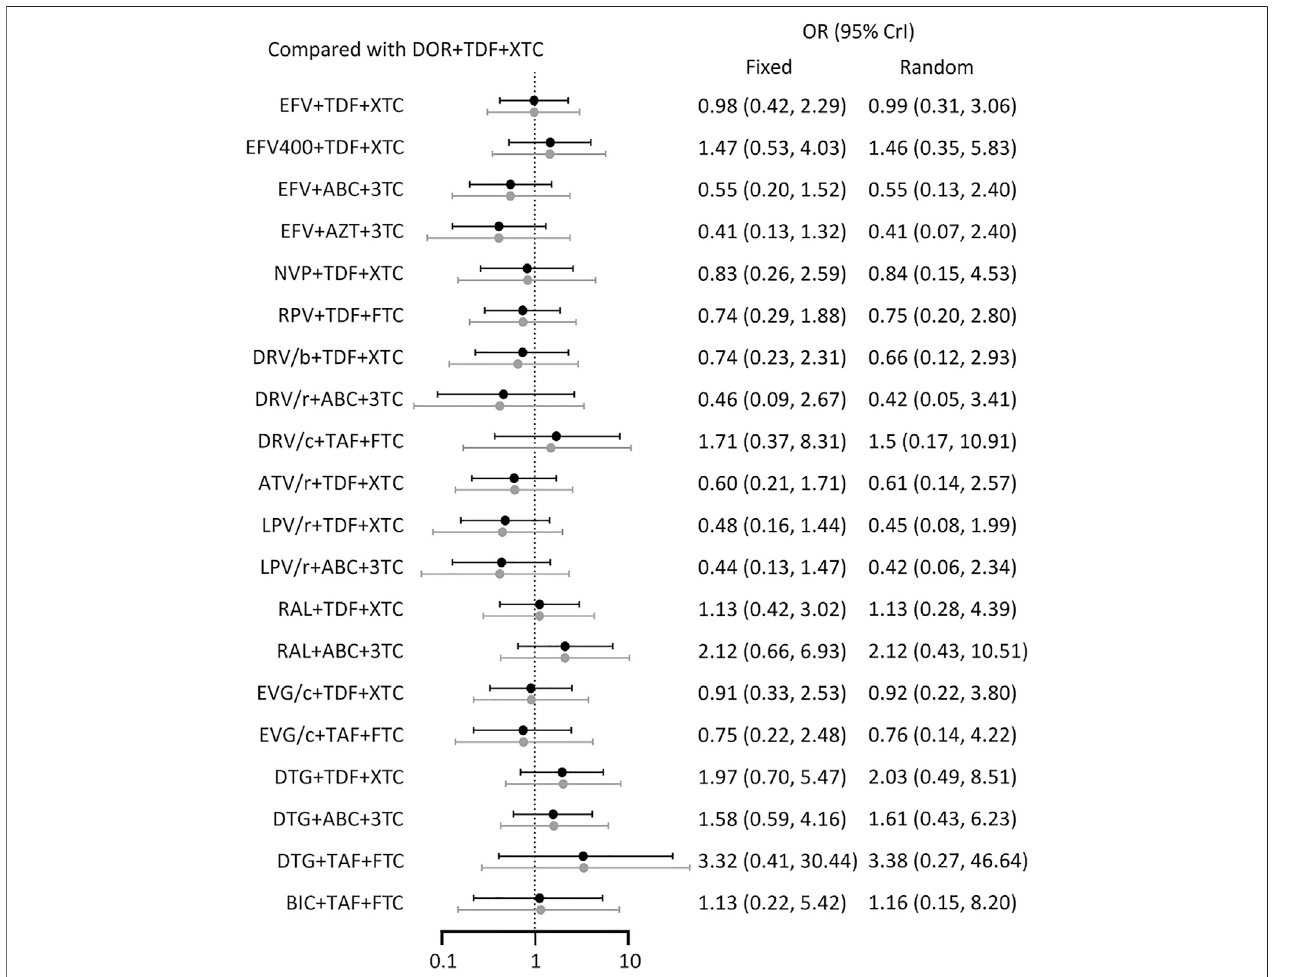
FIGURE 5 | Forest plot of outcomes in terms of subgroup analysis. Results of fi xed effect model were drawn in black, and results of random effect model were drawn in grey. ABC: abacavir; ATV: atazanavir; AZT: Azidothymidine; BIC: bictegravir; c: cobicistat; DOR: doravirine; DRV: darunavir; DTG: dolutegravir; EFV: efavirenz; EVG: elvitegravir; FTC: emtricitabine; LPV: lopinavir; NVP: nevirapine; r: ritonavir; RAL: raltegravir; RPV: rilpivirine; TAF: tenofovir alafenamide; TDF: tenofovir disoproxil fumarate; XTC: emtricitabine or lamivudine; 3TC: lamivudine.